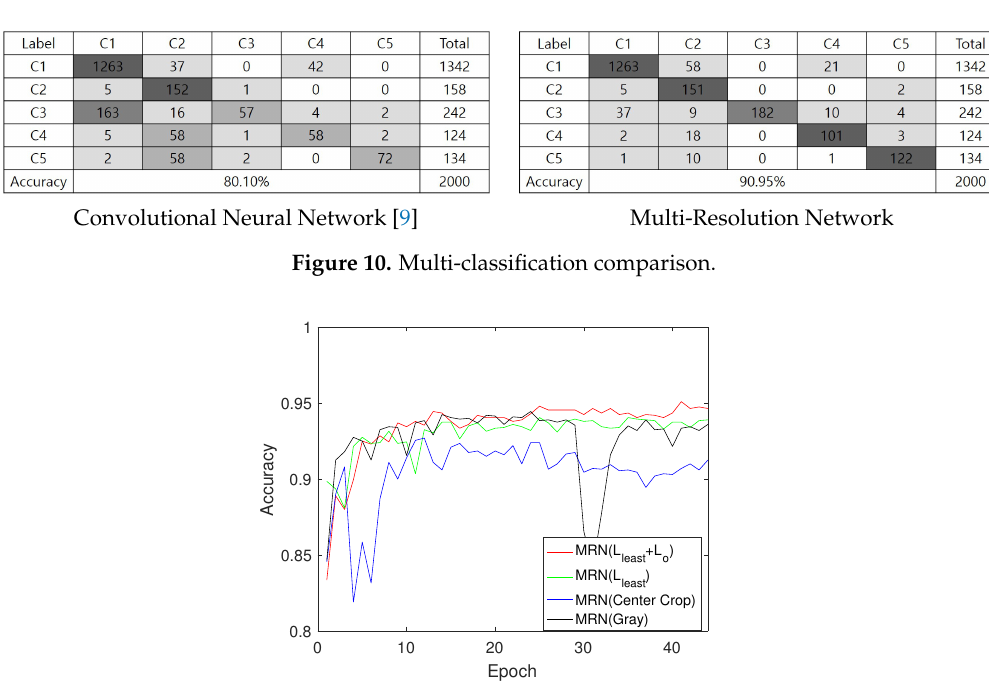
Figure 11. Ablation study: MRN ( L least + L o ) is the proposed orthogonal learning based multi-resolution network (MRN), MRN ( L least ) is the least square loss based MRN, MRN (Center Crop) is the center cropping method to generate the low-resolution image, and MRN (Gray) is a single channel based MRN.